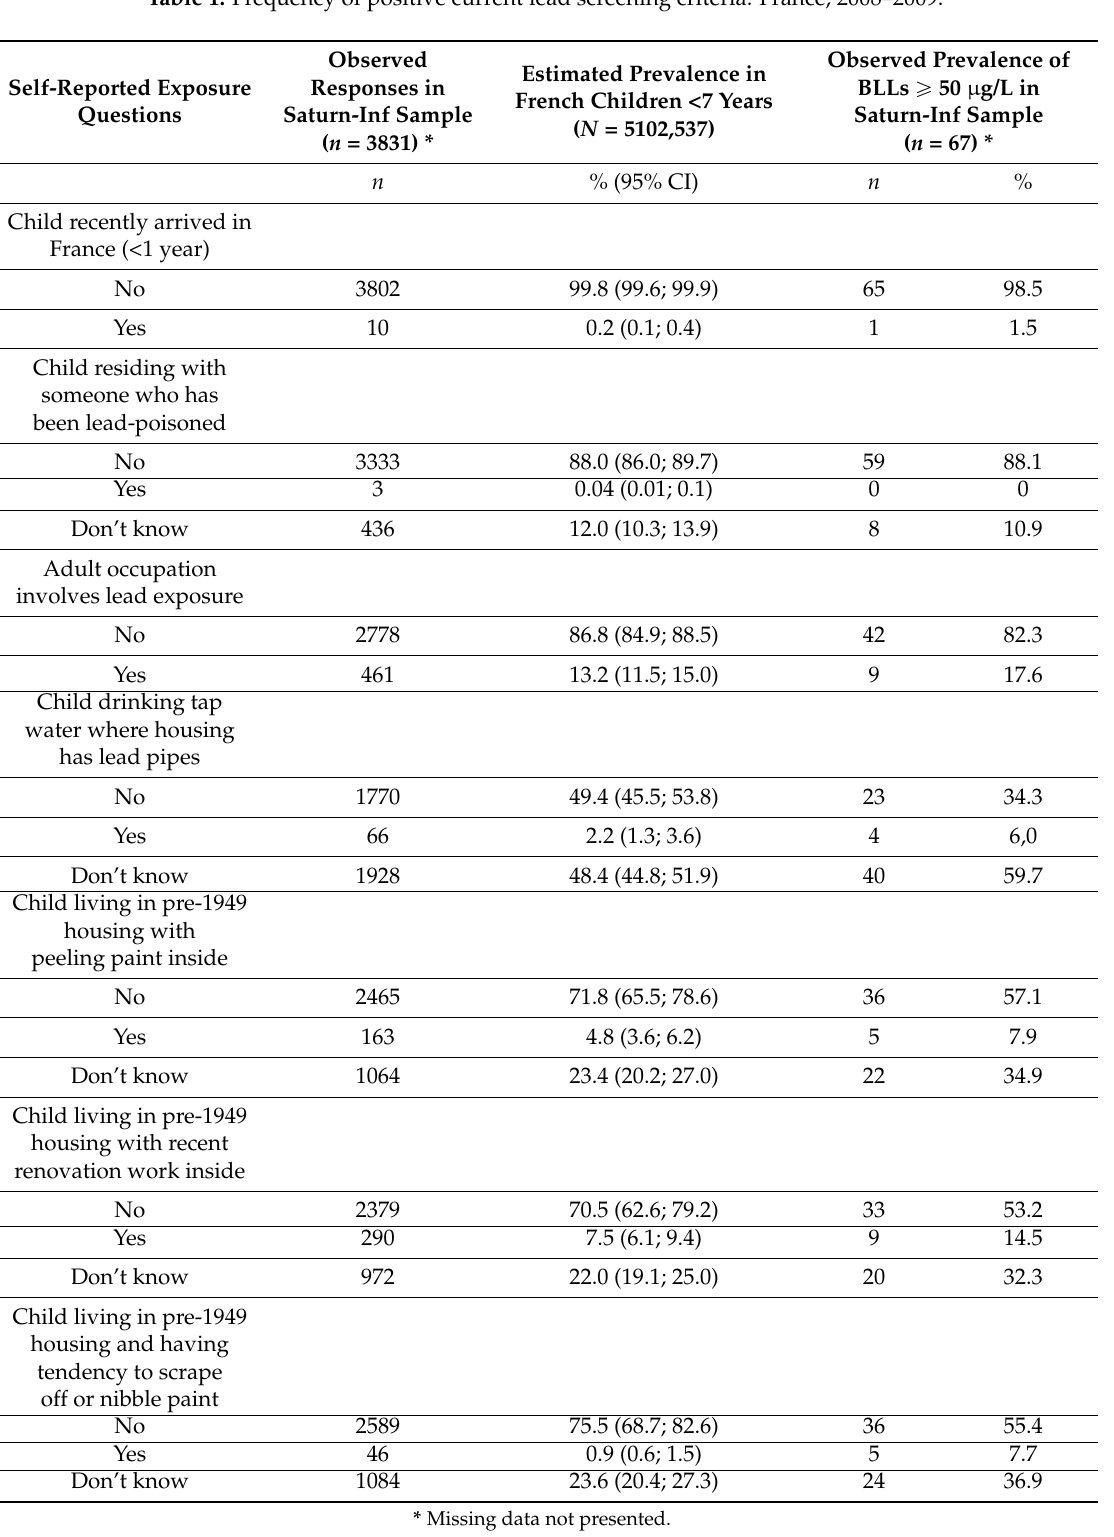
Table 1. Frequency of positive current lead screening criteria. France,